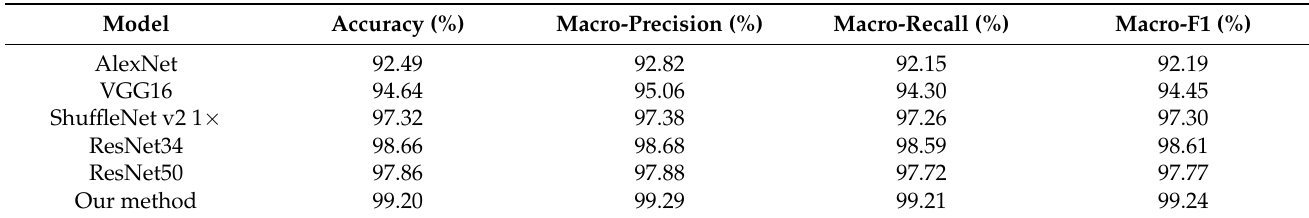
Table 3. Comparison of different